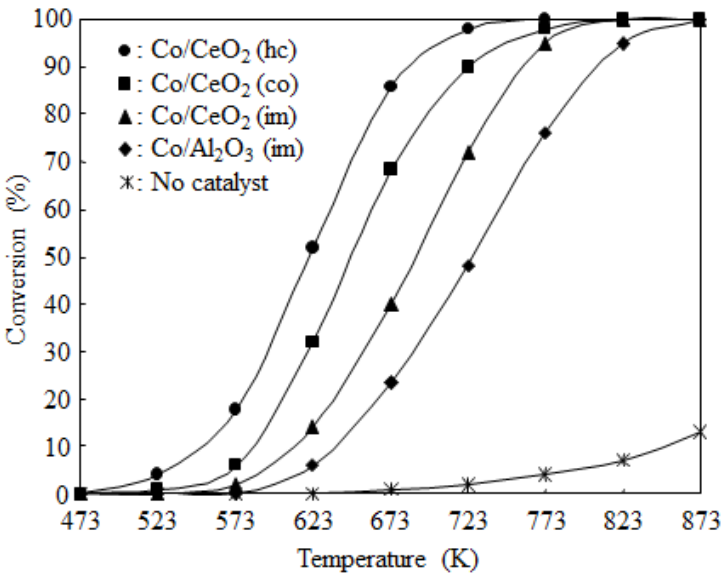
Figure 6. Effect of reaction temperature on the ethanol conversion over various catalysts.